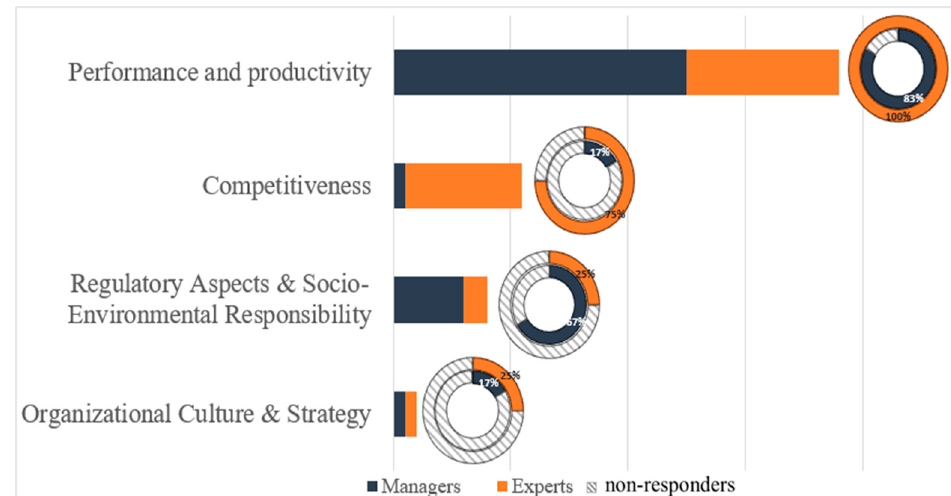
Figure 4. Perception of respondents (Managers and Experts) about the benefits to be achieved with I4.0 in the biopharmaceutical sector—Bar graph: quantity (nº) of citations; pie chart: % of the total respondents in each category they mentioned benefits (Own elaboration).